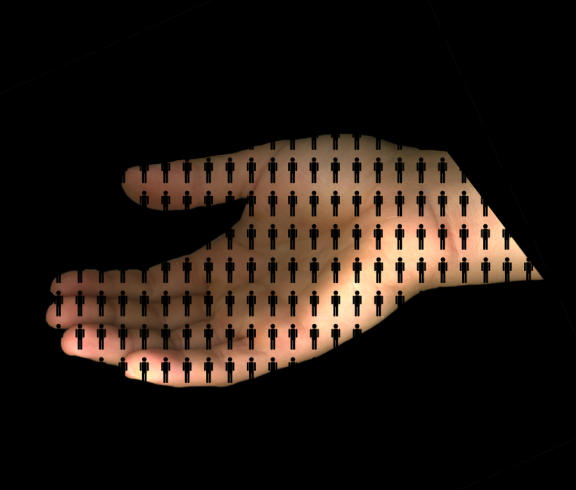
Some policymakers suggest that human cloning would infringe on dignity, but they rarely explain how to judge such infringement(Illustration: Margaret Shear, Public Library of Science)